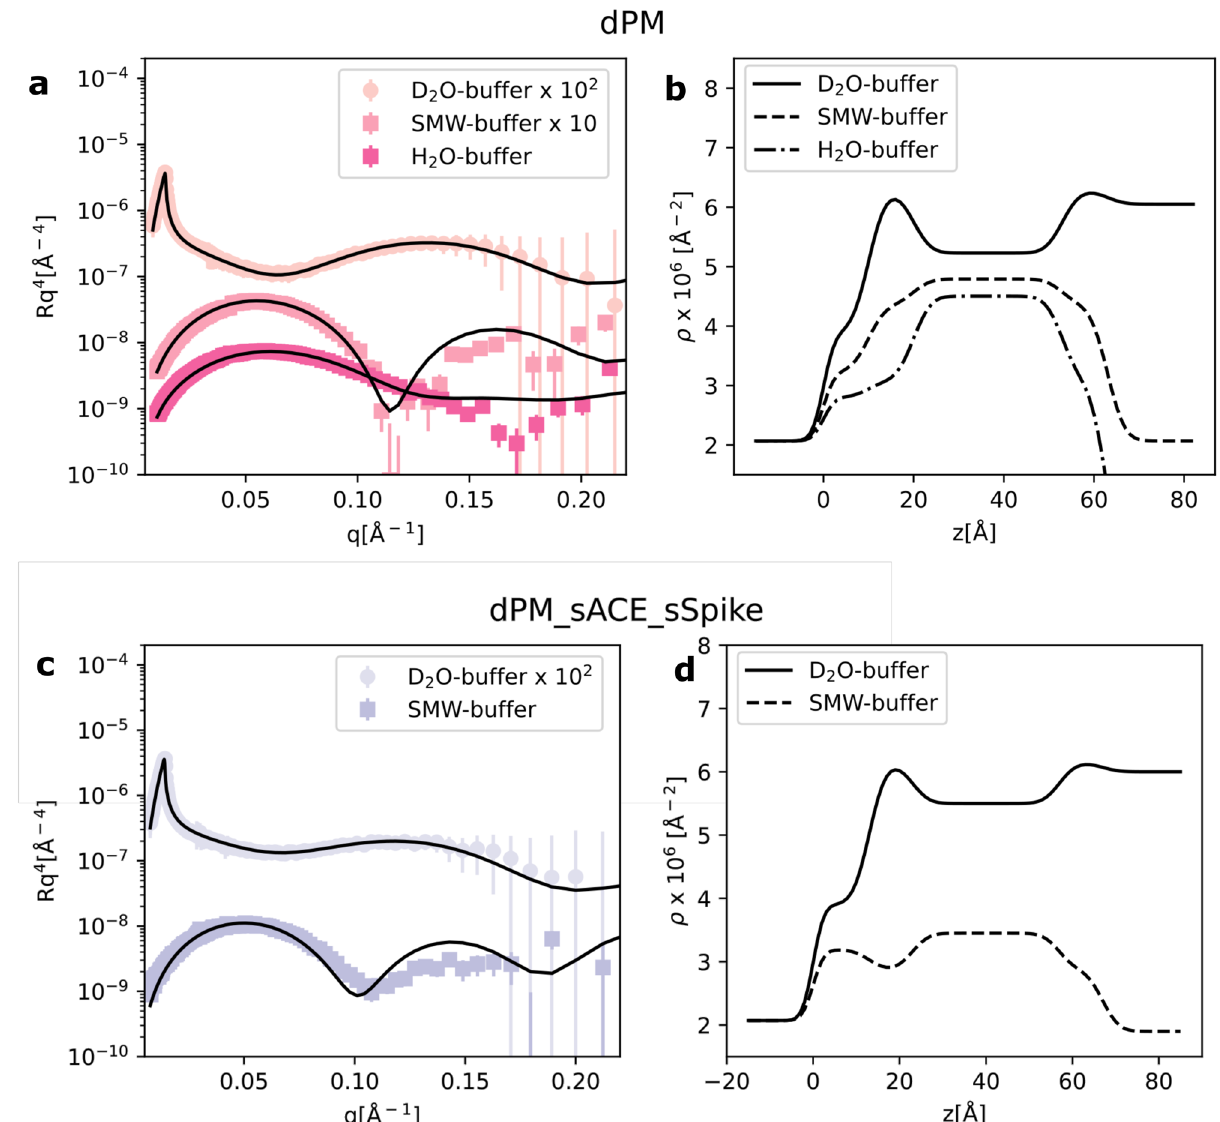
Figure 3. NR experimental data together with the fitting curves from dPM lipid bilayer samples before ( a ) and after sequential injection of sACE2 and sSpike solutions ( c ). Scattering length density profiles determined by NR data analysis ( b , d ). Data and fits are scaled for clarity as reported in the